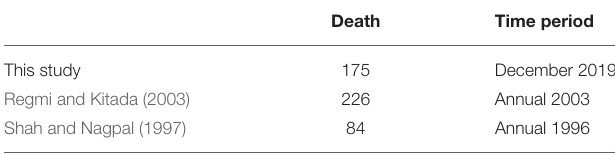
TABLE 4 | Comparison of the results with previous studies for Kathmandu Valley. Death